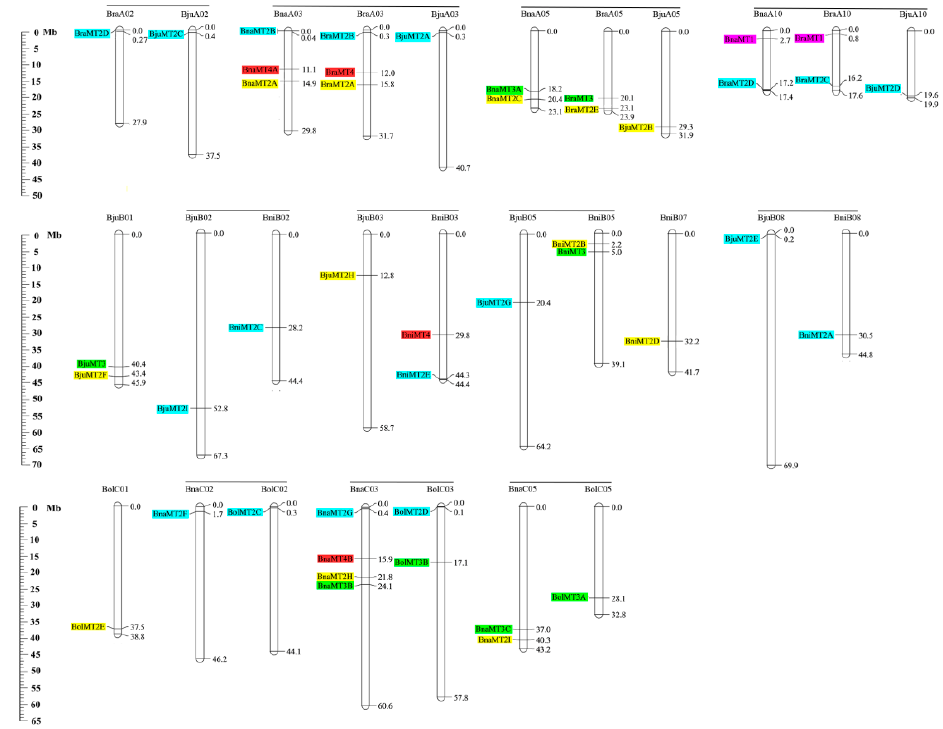
Figure 5. Chromosomal distribution and analysis of duplication events in MT family genes among Brassica species. Genes from the same subgroups are indicated by the same color, which is consistent with the corresponding family in the phylogenetic tree (Figure 1). The labels on the corresponding chromosomes indicate the names of the source organism and the subgenome. The scales indicate the sizes of various Brassica plant genomes (Mb). Bra, B. rapa ; Bol, B. oleracea ; Bni, B. nigra ; Bna, B. napus ; and Bju, B. juncea . The genes located on the scaffold are not shown in the Figure 5.